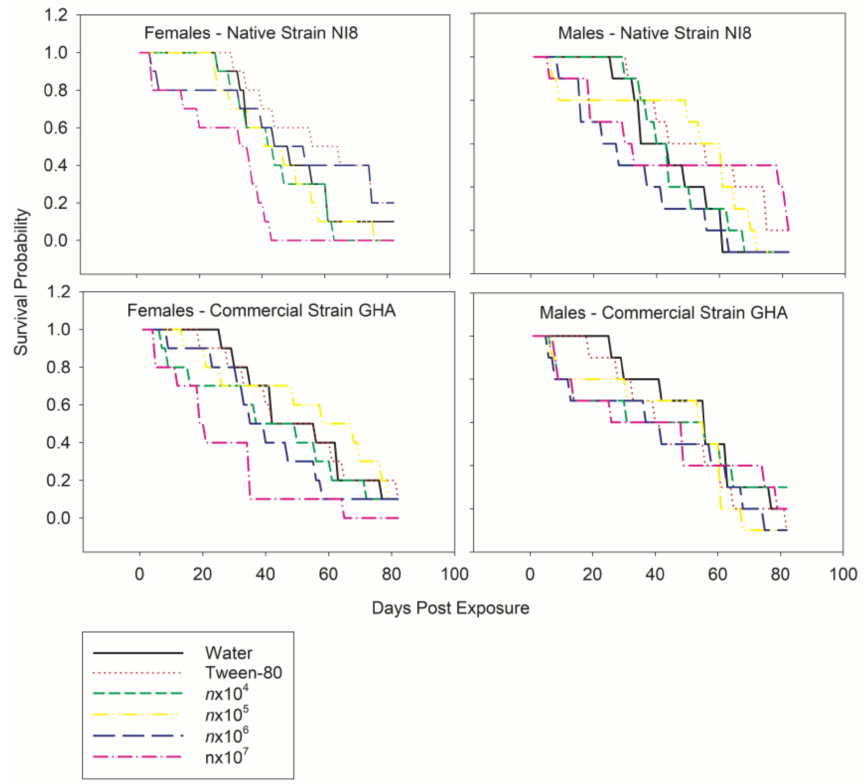
Figure 2. Product-limit survival estimates for females and males of Nezara viridula exposed to 2 strains of Beauveria bassiana NI8 and GHA at different concentrations (spores/mm 2 ). Survival probability at age x ( p = 0.5, LIFETEST of Equality over Strata).